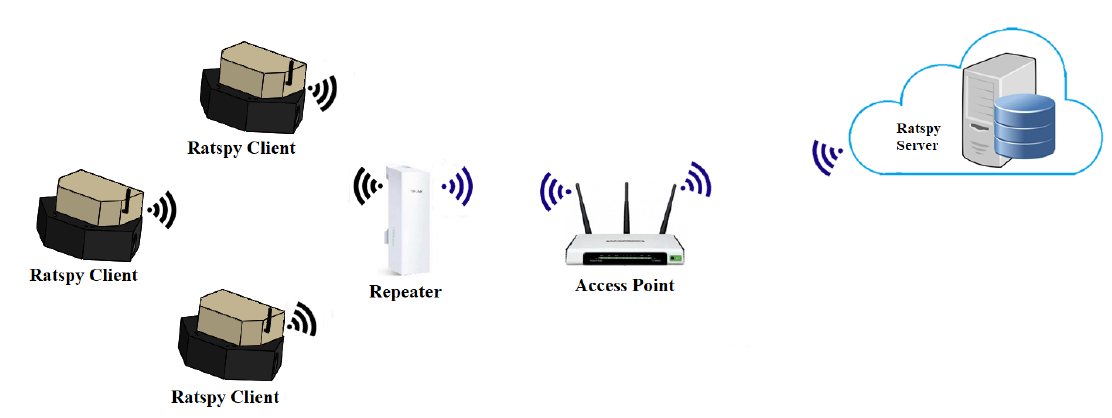
Figure 7. Ratspy Communications